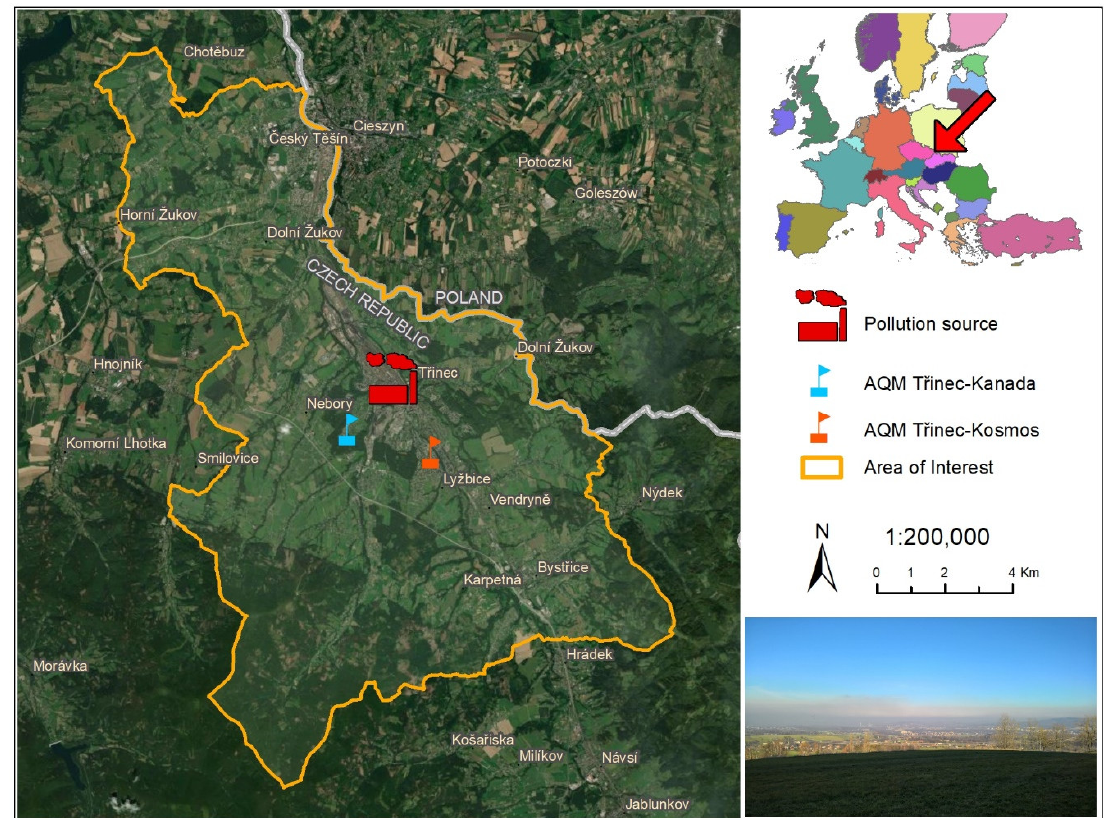
Figure 1 . Situation map of the area of interest (AQM—air quality monitoring). Figure 1. Situation map of the area of interest (AQM—air quality